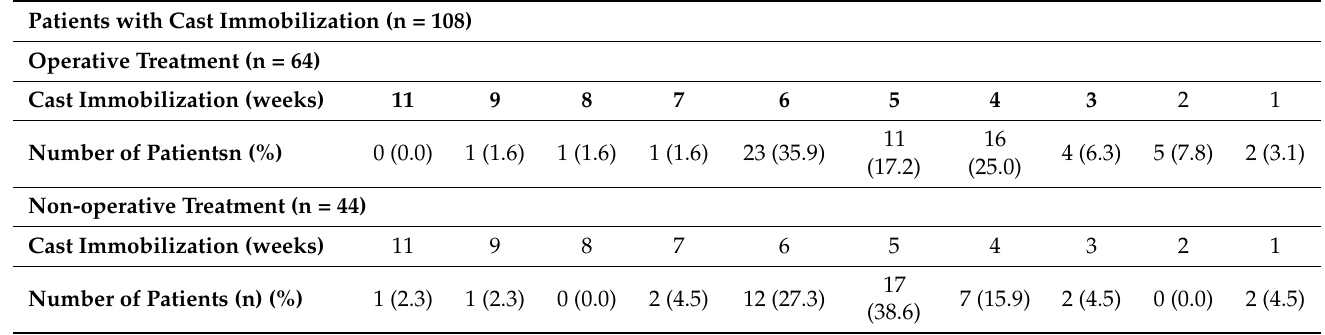
Table 3. Duration of cast immobilization for operative treatment and non-operative